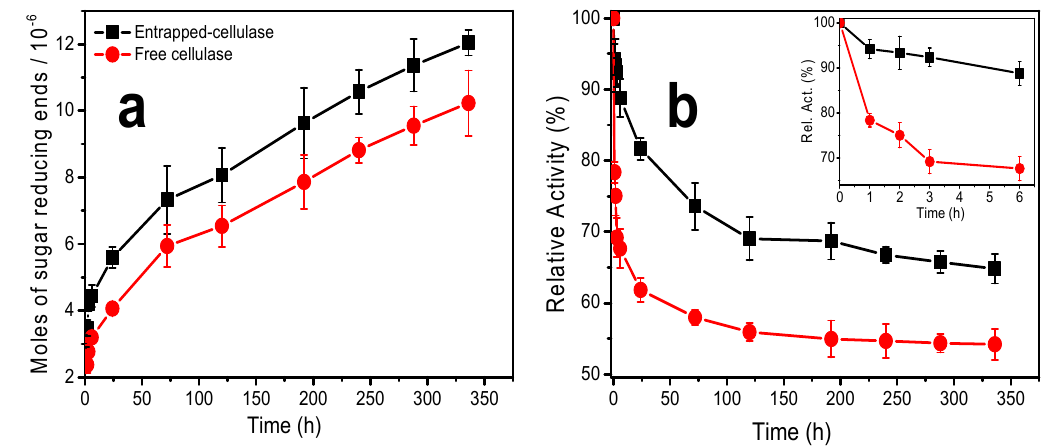
Figure 9. ( a ) Moles of sugar-reducing ends (RE) produced after CNF enzymatic hydrolysis by entrapped and free cellulase at different times; and ( b ) estimated storage stability of entrapped and free cellulase.